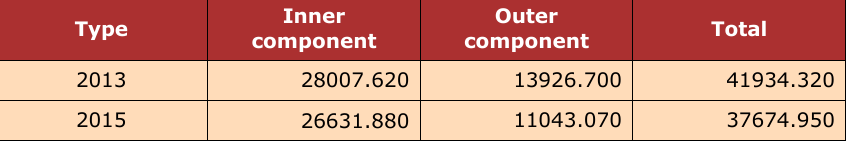
Table 4. Costing table for type 2013 and type